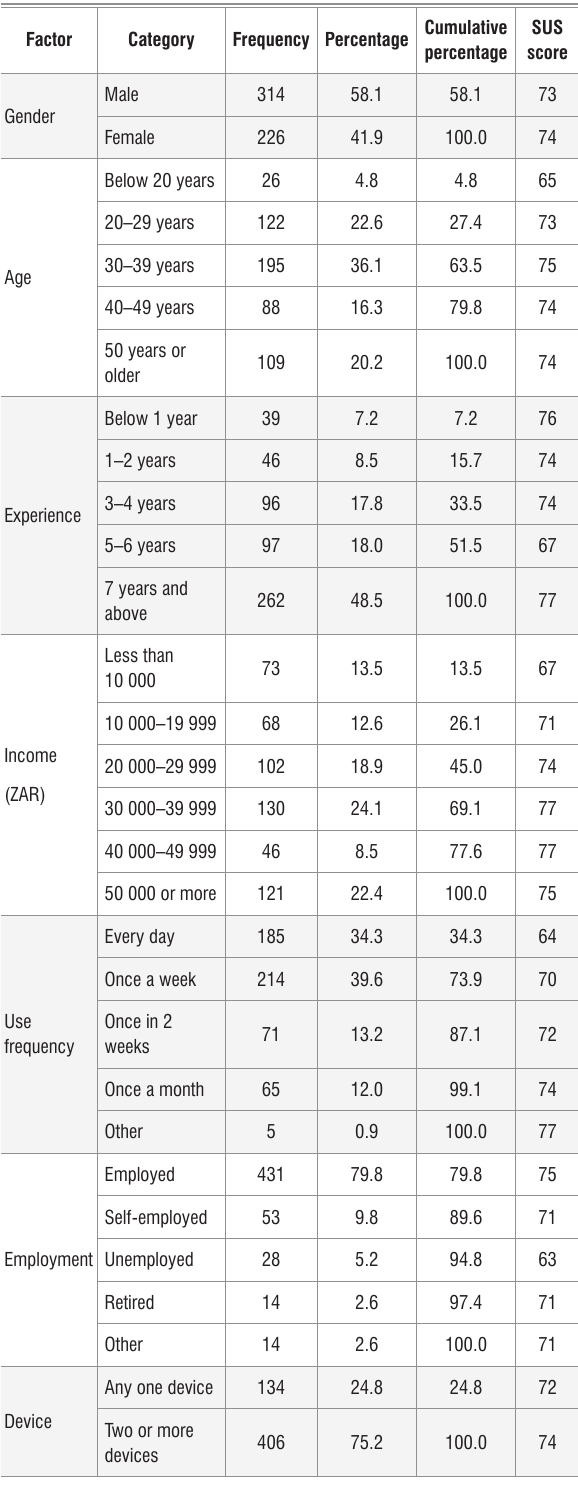
Table 2: Frequencies and mean system usability scale (SUS)